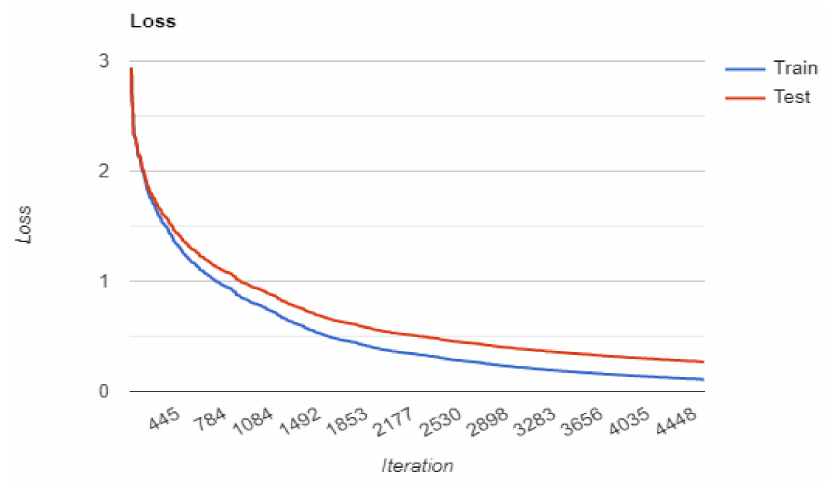
Figure 11. Multi-class loss function convergence with respect to the number of